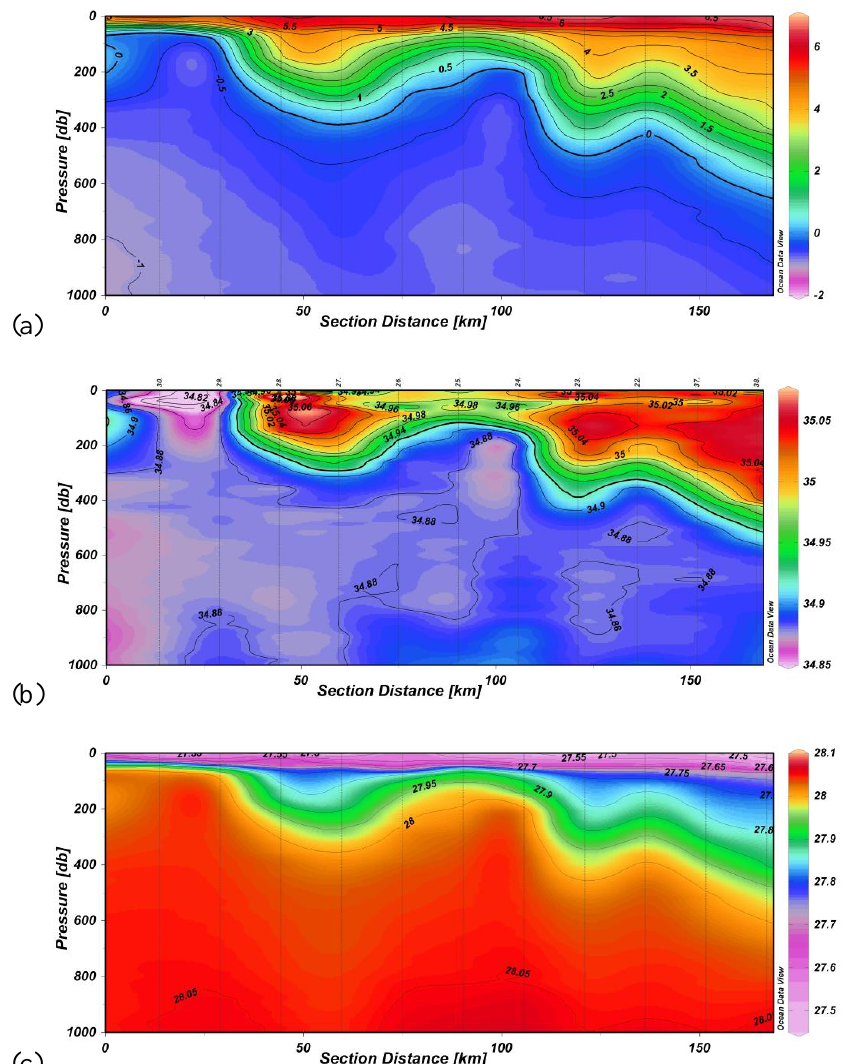
Fig. 9. Section along the 74 ◦ N parallel, across the frontal meander and eddy. (a) Temperature, (b) salinity, and (c) potential density in Figure 9. Section along the 74°N parallel, across the frontal meander and eddy. (a) 4 summer Temperature, (b) salinity, and (c) potential density in summer 1995. 5